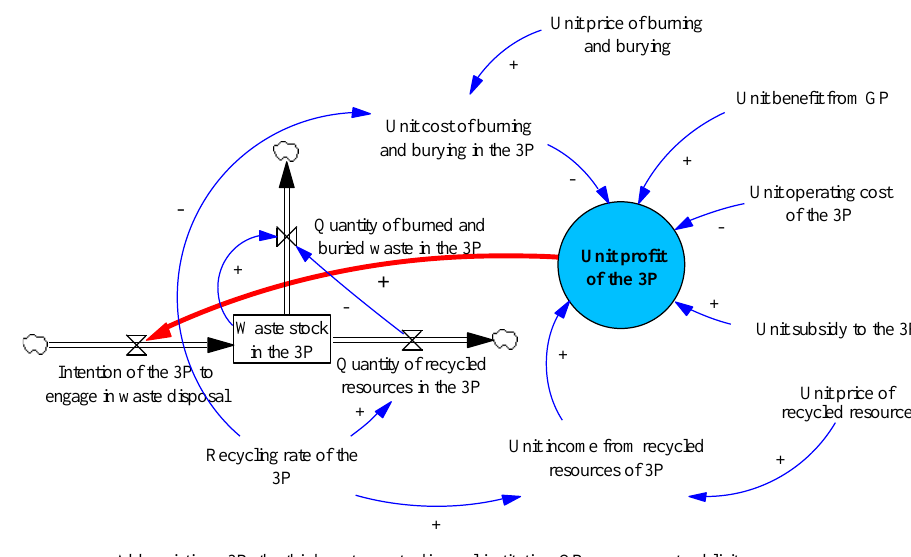
Figure 2. The CLD of 3P Waste disposal module.